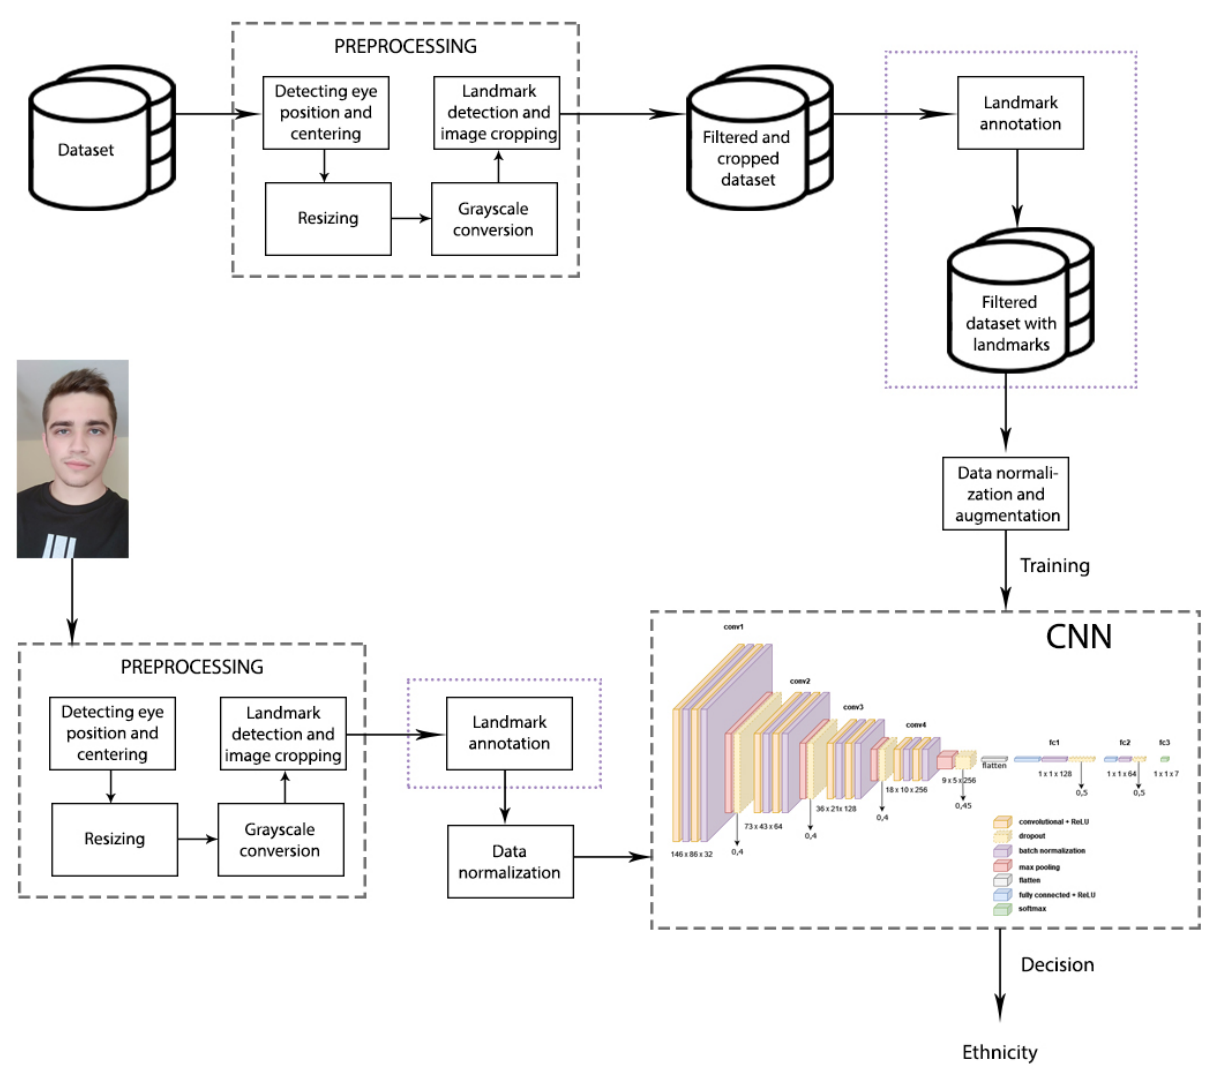
Figure 1. Architecture of the ethnicity classification approach. Purple dotted lines mark the steps which are omitted in the approach without plotted landmarks.